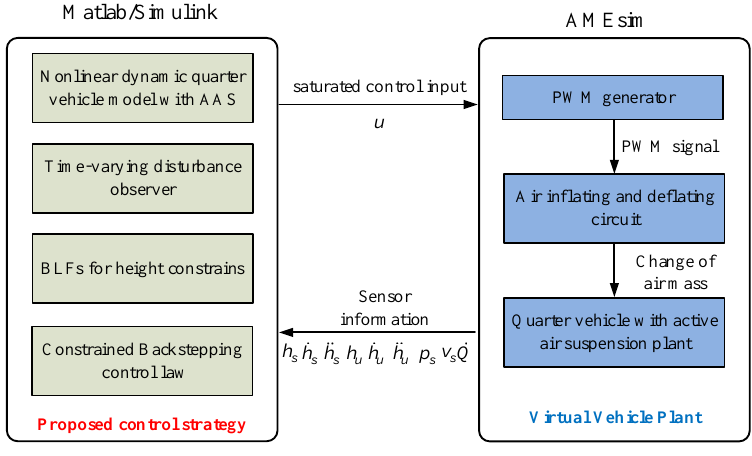
Figure 2. Co-simulation block diagram.